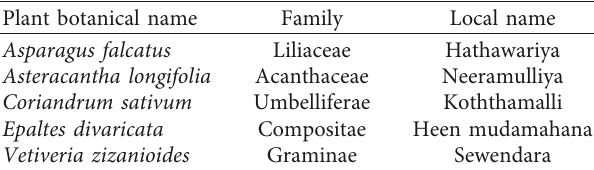
Table 1: Plants used for the